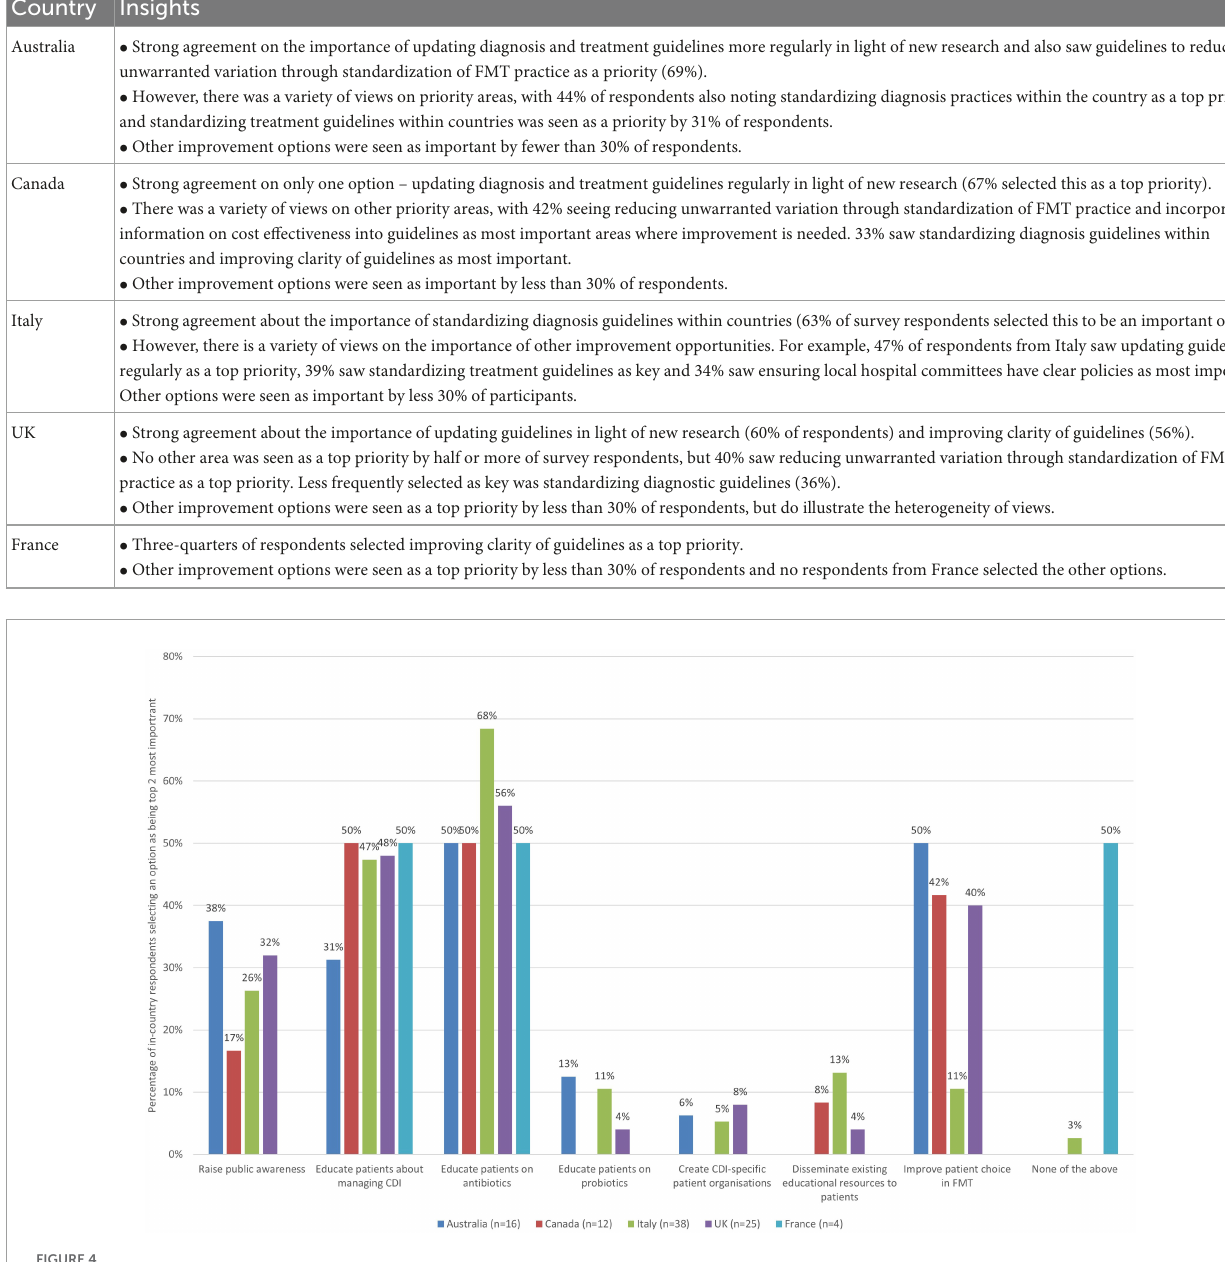
When zooming into country level data, some notable findings are presented in Table 9